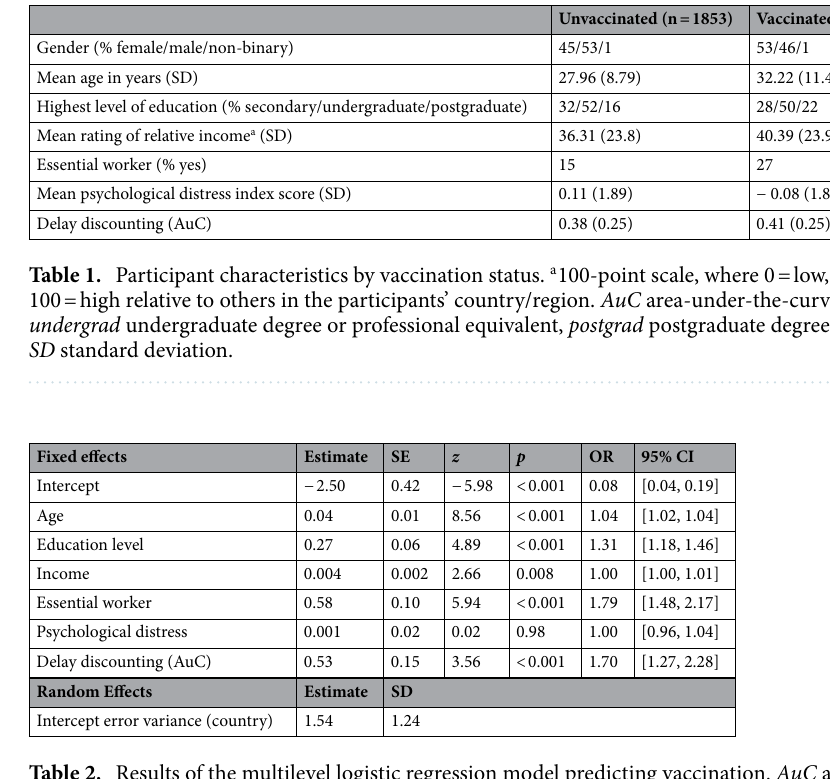
Table 2. Results of the multilevel logistic regression model predicting vaccination. AuC area-under-the-curve, CI confidence interval, OR odds ratio, SD standard deviation, SE standard error.